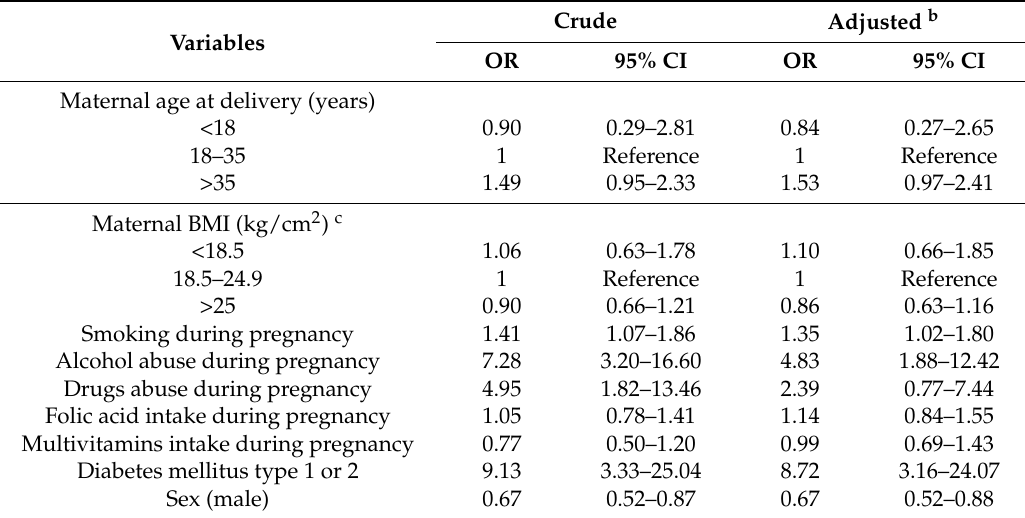
Table 4. Multivariable logistic regression. Crude and adjusted odds ratio (OR) with 95% confidence interval (CI) of ventricular septal defects a for the combined data set of newborns registered in the MCBR and the MRCDR during the period